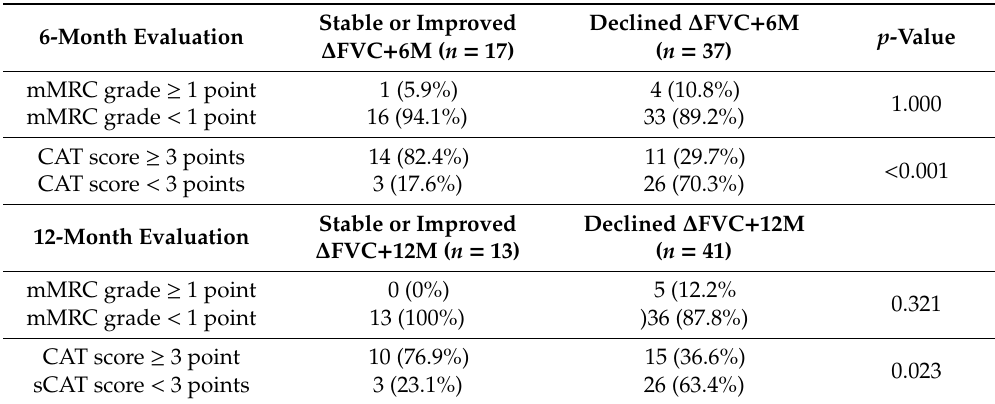
Table 3. Relationship Between Subjective and Objective